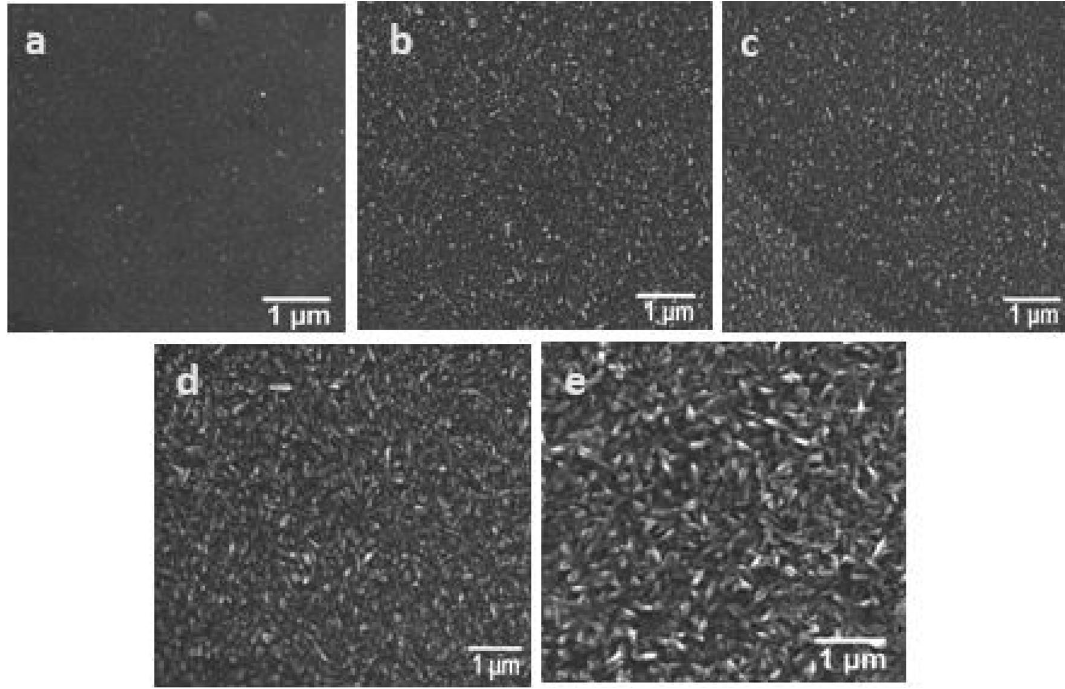
Fig. 2 SEM images of ZnO thin films at a t